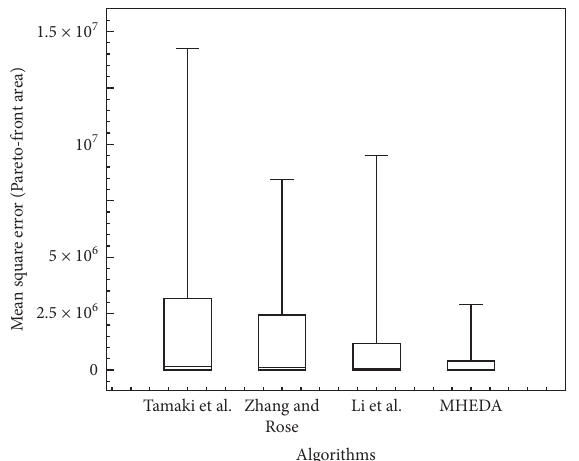
Figure 15: Comparison results for the MHSP using the mean square error.